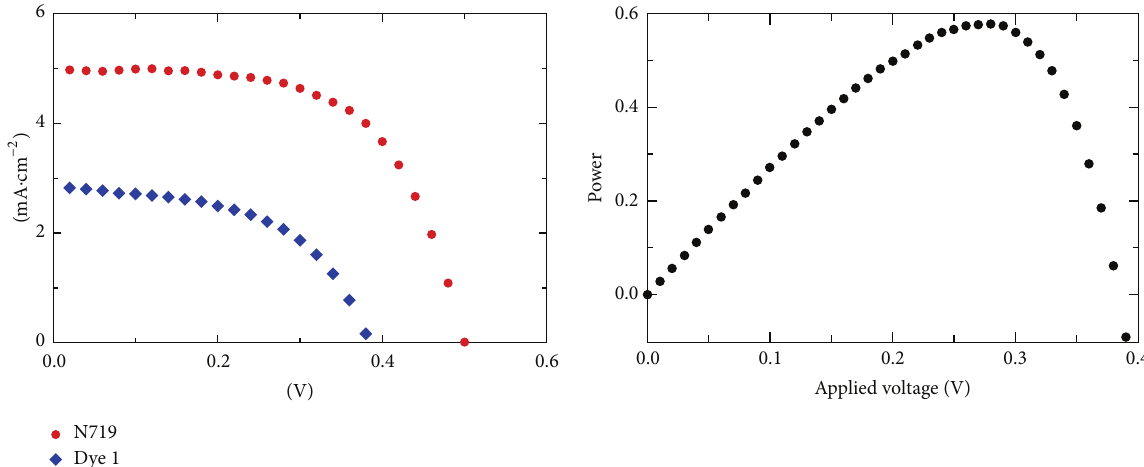
Figure 6: Current voltage plots for light-to-electricity conversion devices (DSSCs) based on amphiphilic Dye (1) and N719 Dye (2) effective surface area of = 0.16cm 2 . Power plot of the amphiphilic dye is also depicted. Visible light (halogen lamp) intensity = 100mW ⋅ cm −2